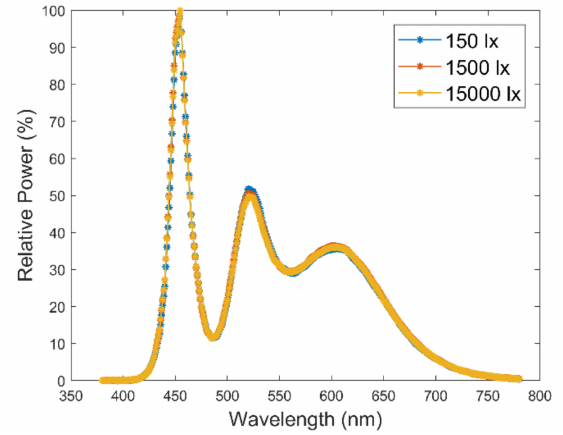
Figure 2. The spectral power distributions (SPDs) of the light sources.